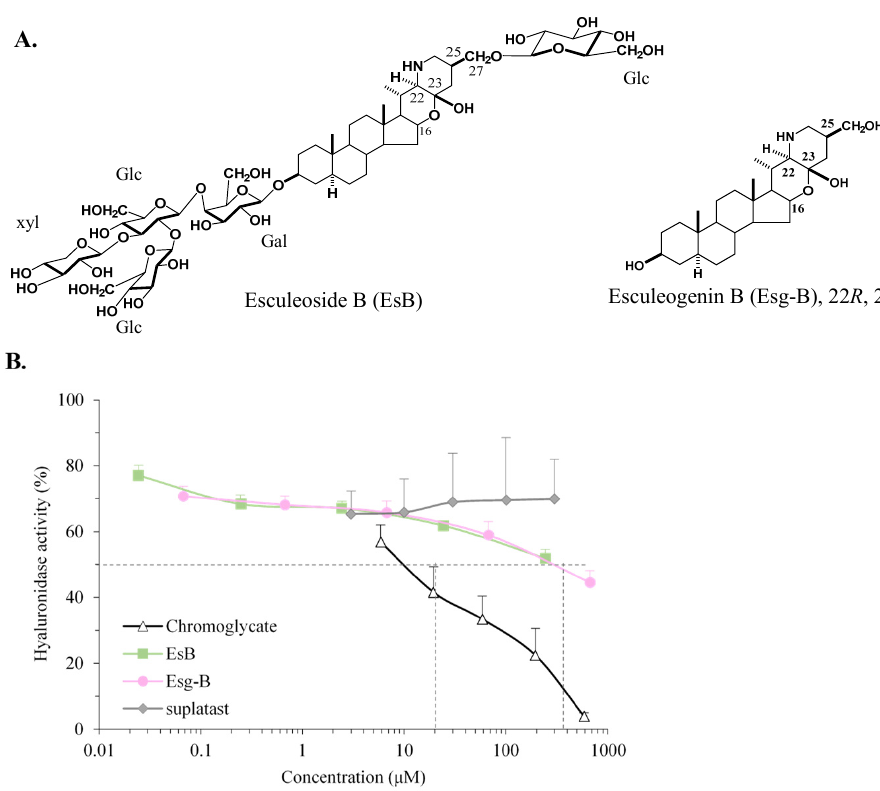
Figure 1. Chemical structures and hyaluronidase inhibition by EsB/Esg-B. ( A ) The chemical structures of EsB and Esg-B. Glc: Glucose; Gal: Galactose; Xyl: Xylose. Molecular weight: 1228.34 g/mol (EsB); 447.33 g/mol (Esg-B). ( B ) Dose-dependence of EsB/Esg-B on the inhibition of hyaluronidase activity. The results represent five independent experiments, and each bar is expressed as mean ±